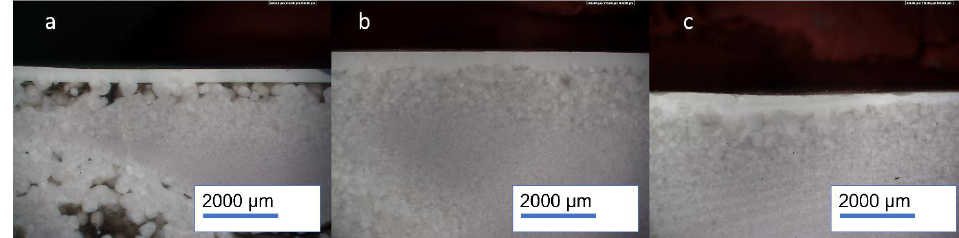
Figure 8. Optical microscope images of samples of parent glass C1 heat treated at 850 °C for 1 h ( a ) and 5 h ( b ) and at 900 °C for 0.5 h ( c ).